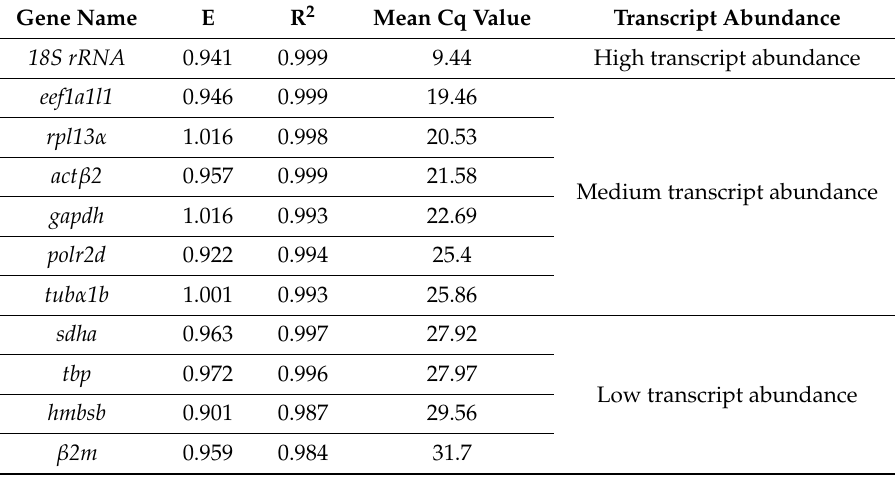
Table 1. Transcript abundance and amplification efficiency of candidate reference